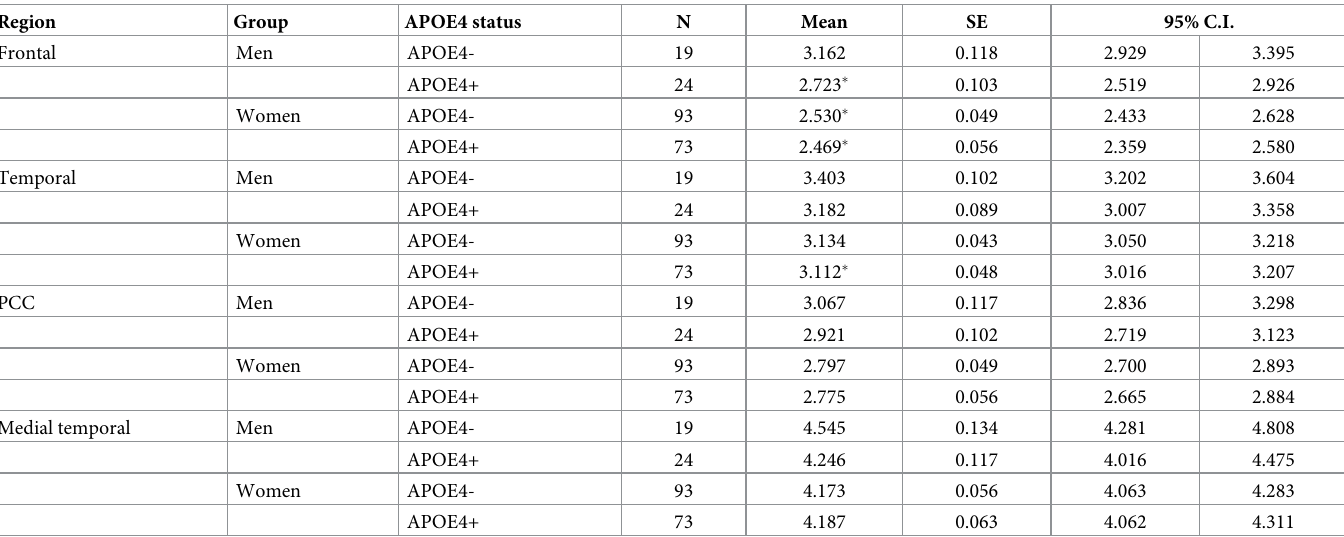
Table 2. Regional PCr/ATP by sex and APOE4 status.